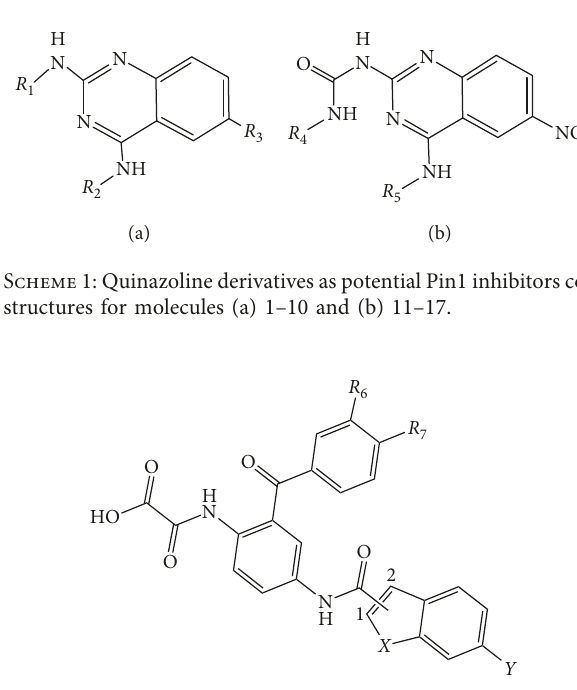
Scheme 2: Series of Pin1 inhibitors with benzophenone skeleton core structure for molecules